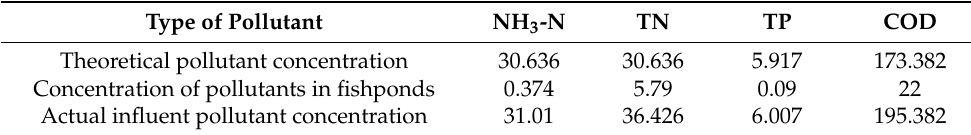
Table 2. The actual inlet water quality of the test. Unit